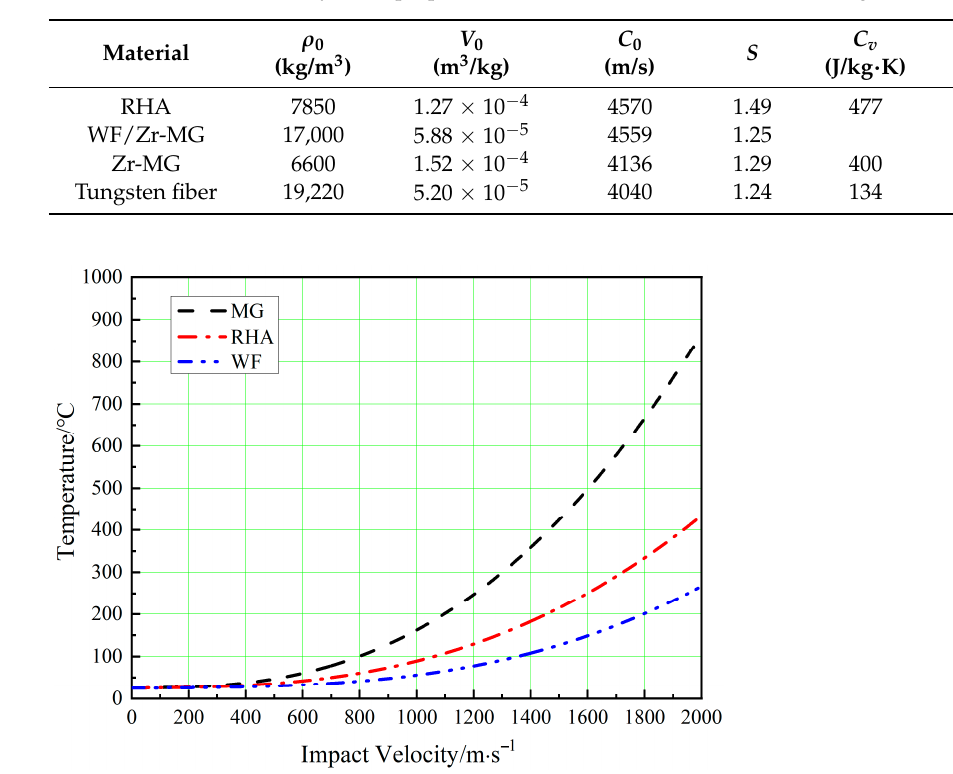
Table 3. Shock and thermodynamic properties of RHA, WF/Zr-MG, Zr-MG, and tungsten fiber [25,26].